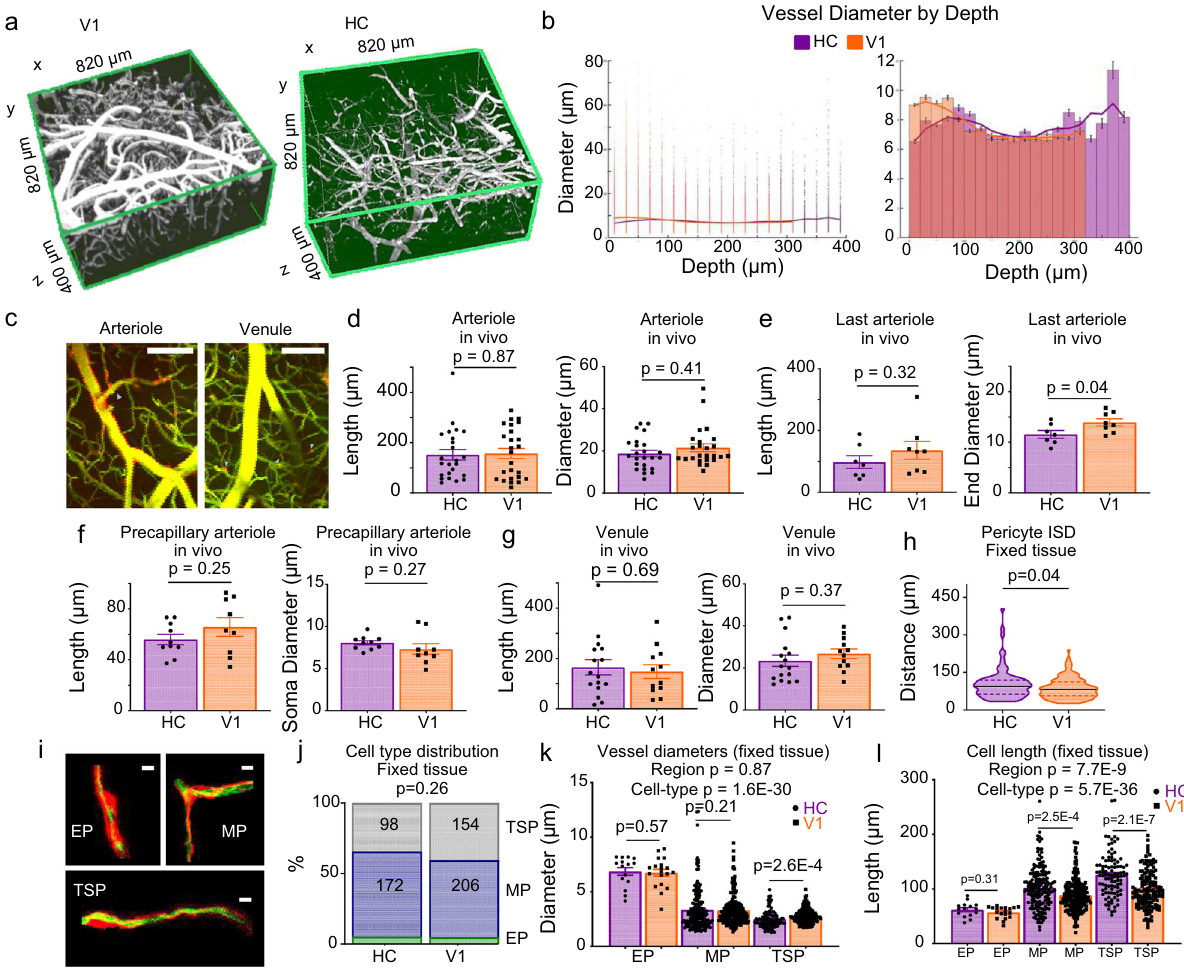
Fig. 6 Vascular morphology across brain regions. a Example in vivo Z-stacks of vasculature in V1 (left) and HC (CA1, right, as used in b ). b Left panel: all data points for vessel diameters by depth from the pia in V1 (48458 vessels collapsed from nine stacks/nine animals, orange) or layer SO in HC (21175 vessels collapsed from 8 stacks/6 animals, purple). Right panel: histogram of average ±SEM of these vessel diameters by depth. The overlaying lines are a smoothed trace of the average diameter per bin. c Example arteriole (left) and venule (right) from an in vivo Z-stack of CA1 in a NG2-DsRed mouse with FITC dextran- fi lled vessels (representative image from N = 3 stacks from different mice per region). Scale bars represent 100 µ m. The termination point of an arteriole was the fi nal smooth muscle cell before an ensheathing pericyte (blue arrow). Venule termination points were the fi nal branch before the capillary bed, identi fi ed by the presence of distinct pericytes. Dots represent individual vessels ( N = 3 stacks from different mice per region). The diameter and length of d arteriole branches were not different between HC (purple, N = 24) and V1 (orange, N = 25). e The diameter of the vessel at the fi nal SMC was signi fi cantly smaller in HC ( N = 7) vs V1 ( N = 8), despite similar vessel lengths. f The precapillary arterioles (with ensheathing pericytes, HC N =